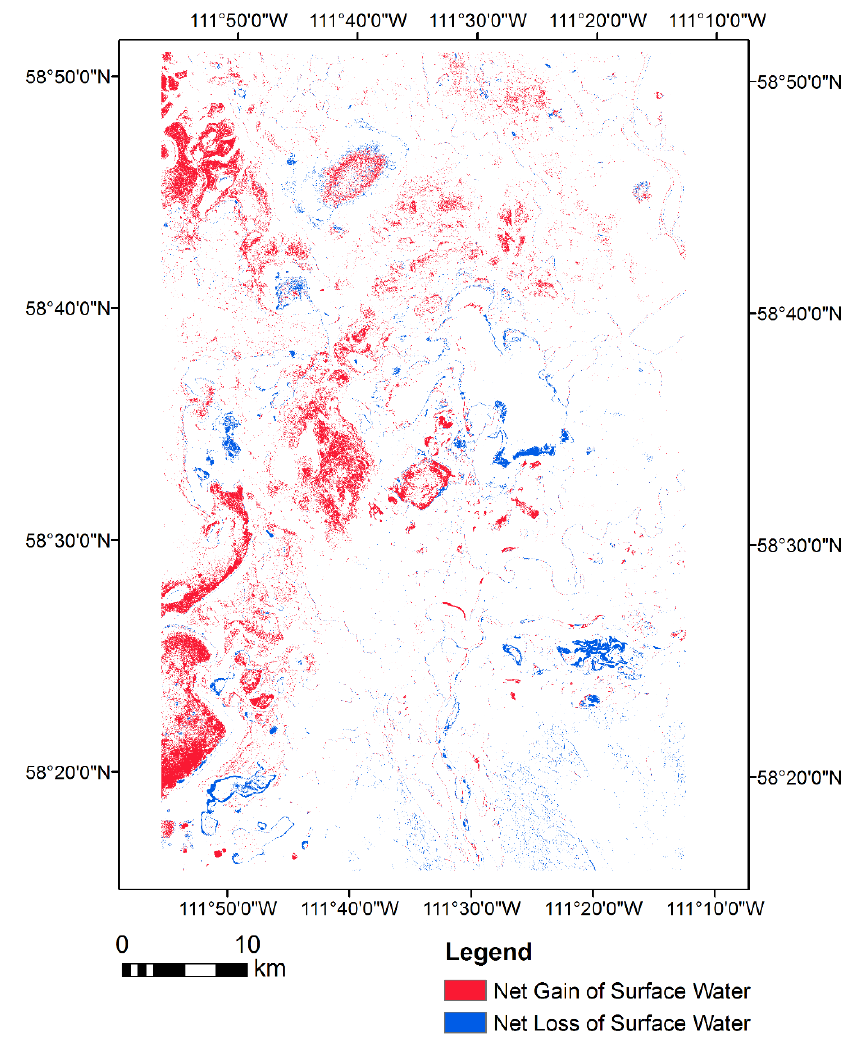
Figure 5. These images show the location of net gain (red) and net loss (blue) of water from 28 April 2012, to 13 October 2012, in the Peace-Athabasca